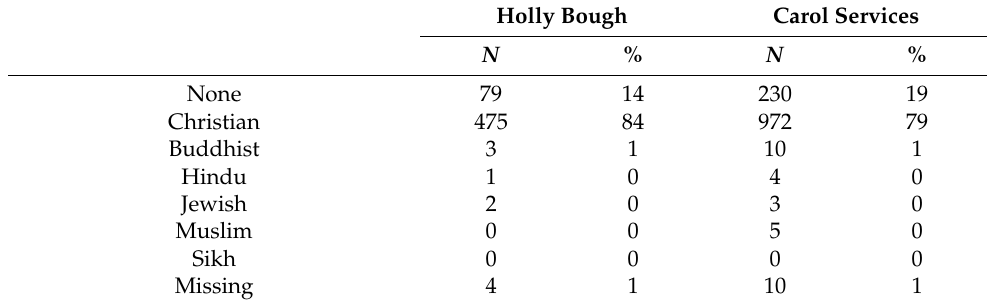
Table 8. Religious